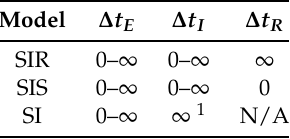
Table 2. Shows the dwell times in different disease states for SIR, SIS and SI disease models [21].